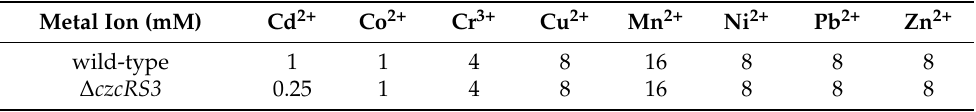
Table 1. Minimum inhibitory concentration (MIC) of heavy metals for wild-type P. putida KT2440 and ∆ czcRS3 in LB medium.